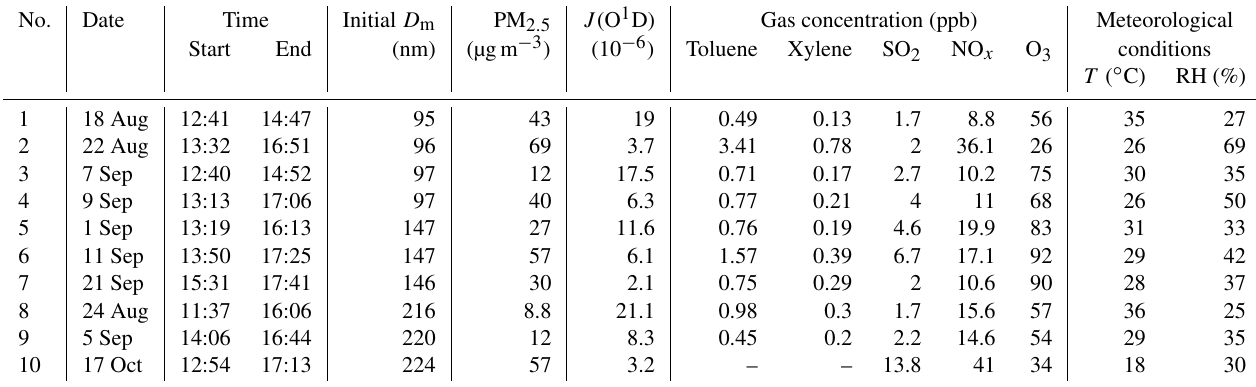
Table 1. Summary of ambient conditions for BC ageing experiments conducted in Beijing. The PM 2 . 5 , gas concentrations and meteorological condition were averaged from the entire experimental time. D m and T represent the mobility diameter and